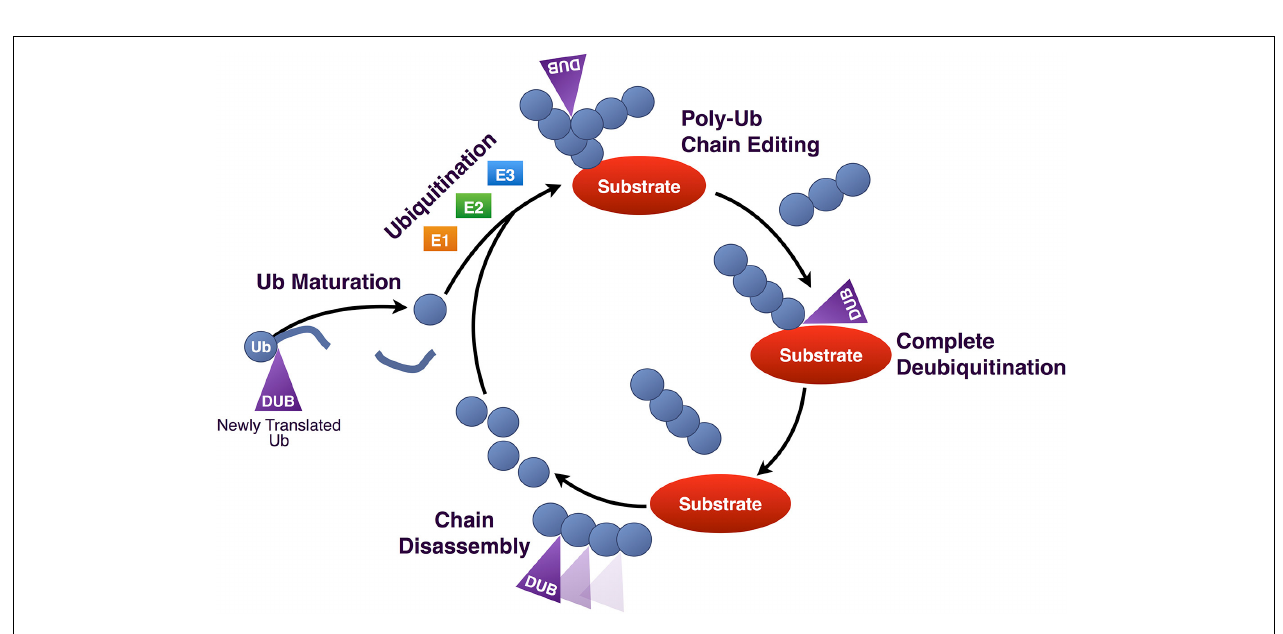
FIGURE 3 | Roles of DUBs in Ub homeostasis. Diagrammatic summary of the various functions of DUBs in Ub homeostasis. Newly produced Ub is C-terminally fused to other proteins, such as other Ub molecules, and must be cleaved by DUBs in order for its terminal glycine residue to be exposed for